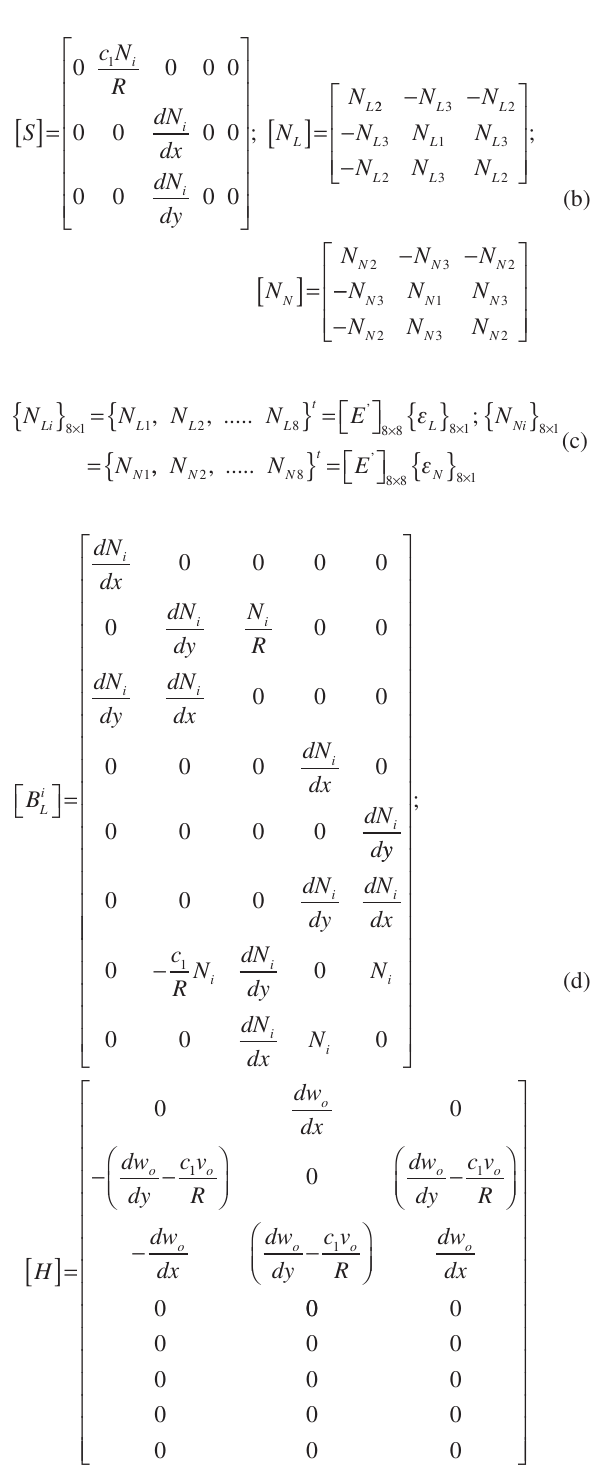
= v = 0 = 0; u ˝ 0v o = 0(e) u o o o , v , w where ( u ) denotes the mid-plane displacement fi eld o o o that refers to the global coordinate system (x, y, z) as shown in Figure 1 ; L and b are the length and width of the plate, respectively. The above Figures A-2 and A-3 are the re-plot of Figure 2 from which the stability limit load is calculated at the point where the transverse defl ection increased signifi cantly with the small increment of compressive load; this value is to be equal to 129 MPa. The neighborhood of limit load of Figure A-2 is plotted in Figure A-3 to show the critical point where the transverse defl ection increased signifi cantly with the small change of compressive load.